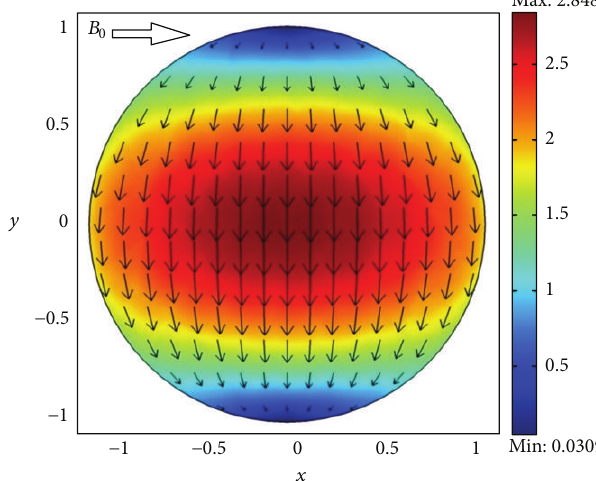
Figure 16: The surface plot shown in color is the magnitude of the electric field and arrow plots indicate the direction of induced elec- tric field. The plot is showing in steady case in the far downstream for Re = 300 and Ha = 2 .